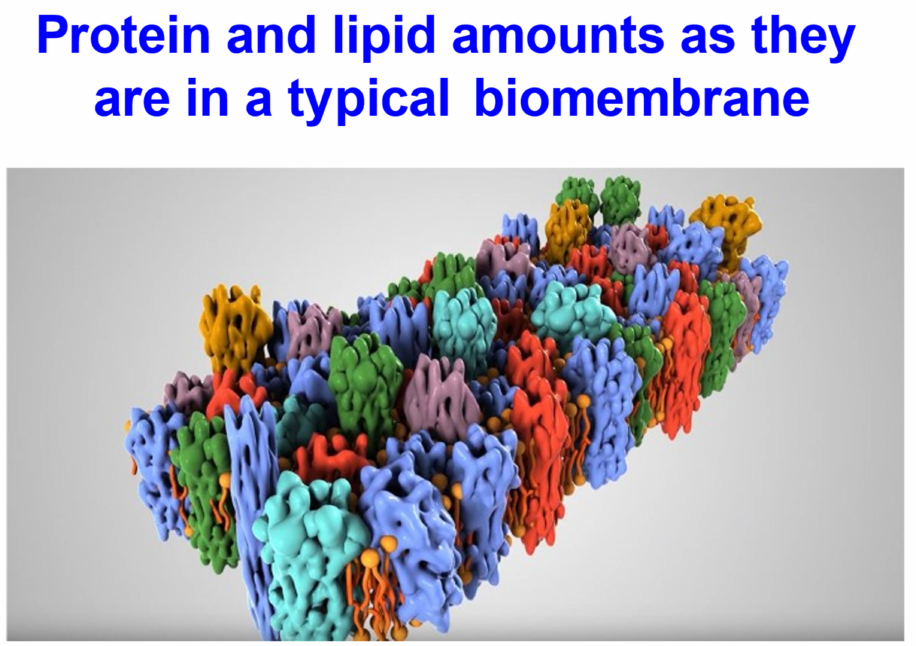
Figure 2. Cartoon of a typical biomembrane indicating the relative paucity of phopholipid bilayer that is uninfluenced by proteins. Taken from an Open Access animation covering some of this ground and related transporter matters at